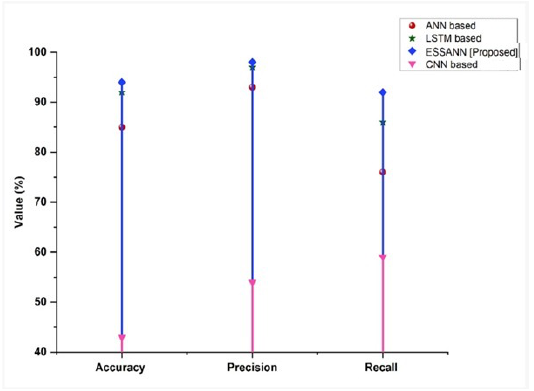
Figure 9. Comparison of accuracy, precision, and recall.